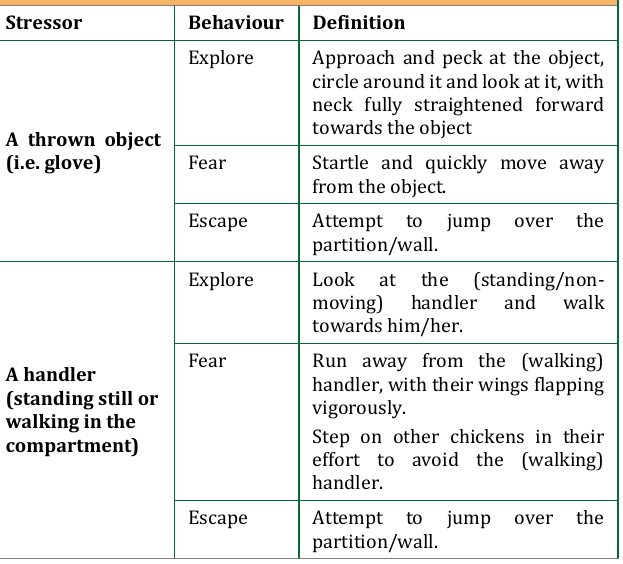
Table 1: Ethogram used for novel object test.